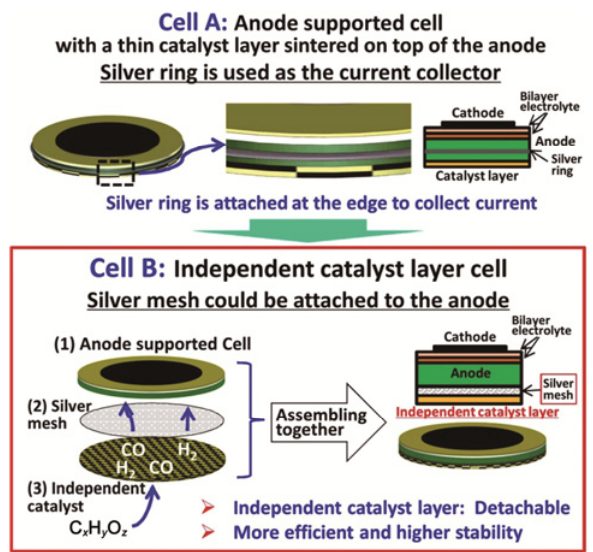
Fig. 1 Schematic diagram of anode-supported cell with a thin catalyst layer (Cell A) and the cell with an independent catalyst layer (Cell